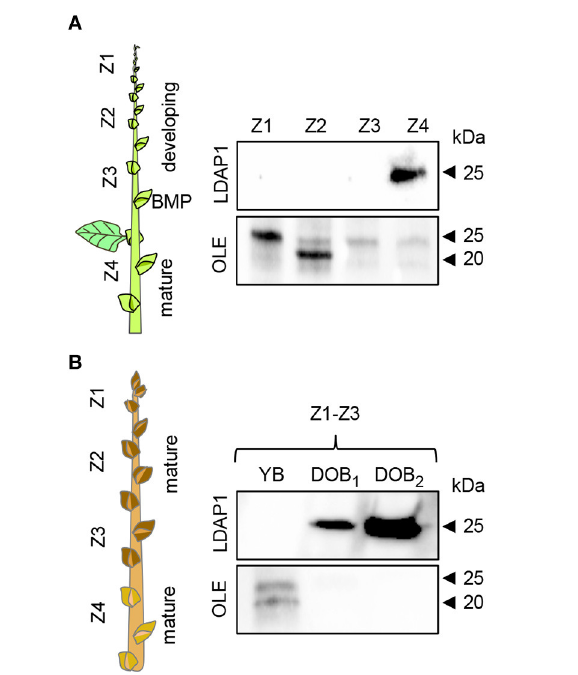
FIGURE 6 | Immunodetection of LDAP1 and OLEOSIN proteins in axillary buds during their maturation under different daylength conditions.